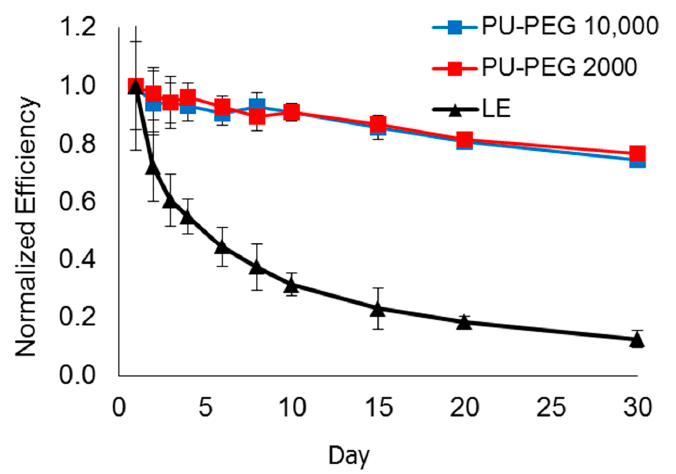
Figure 10. Lifespan of DSSCs based on PU matrices with different PEG molecular weights for 30 days